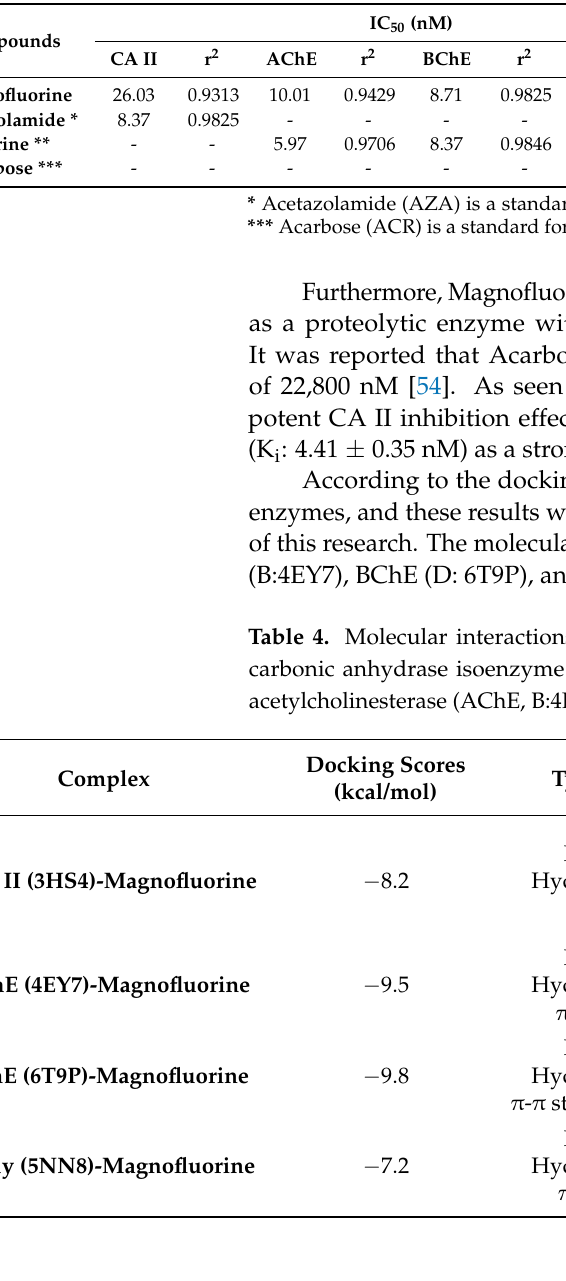
Table 3. Inhibition values of Magnofluorine against α -glycosidase ( α -Gly), carbonic anhydrase isoenzyme II (CA II), butyrylcholinesterase (BChE), and acetylcholinesterase (AChE) enzymes.